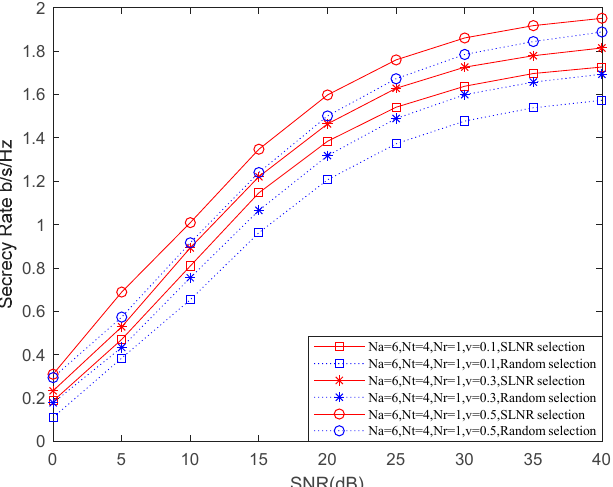
Figure 2. SR over SNR under different schemes for different 𝑣 .